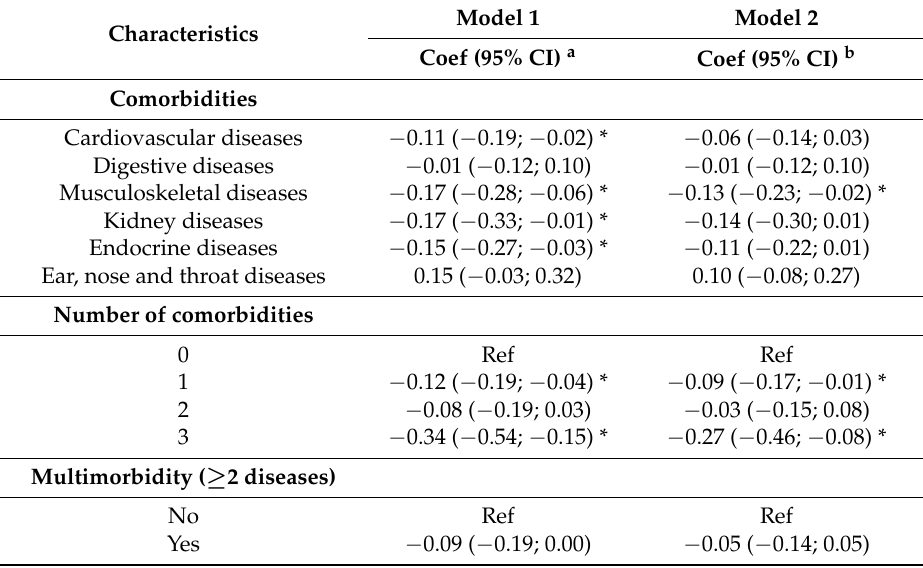
Table 4. Correlations between EQ-5D-5L index and